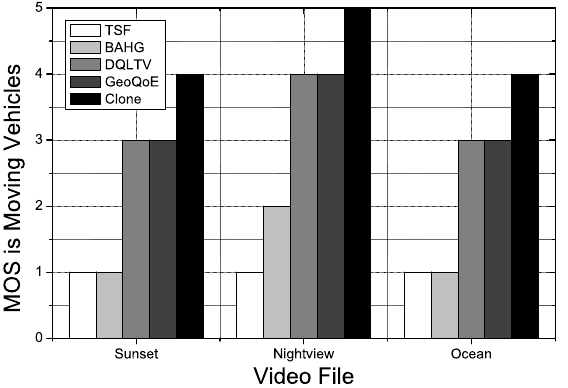
Figure 16. MOS for each video file in a mobility scenario.